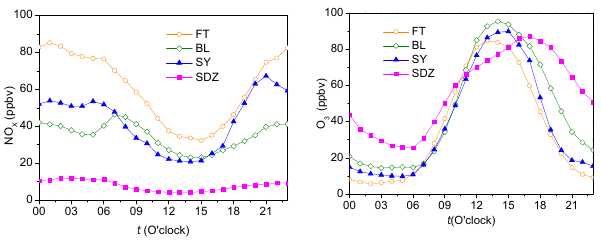
Fig. 8. Average diurnal variations of NO x and O 3 concentrations Fig.8 Average diurnal variations of NO x and O 3 concentrations observed at the four sites 2 observed at the four sites (Beijing (Beijing time). 3